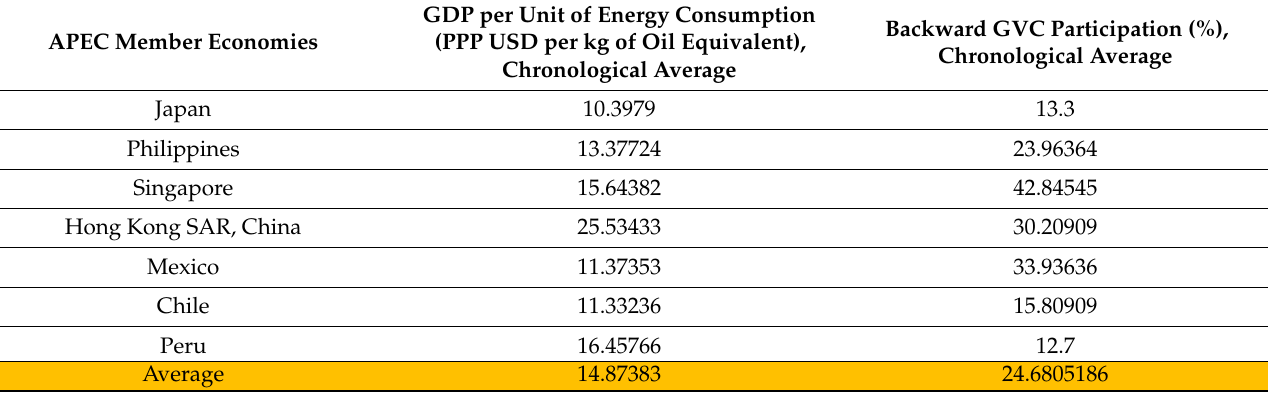
Table 8. APEC member economies with higher GDP per unit of energy consumption.